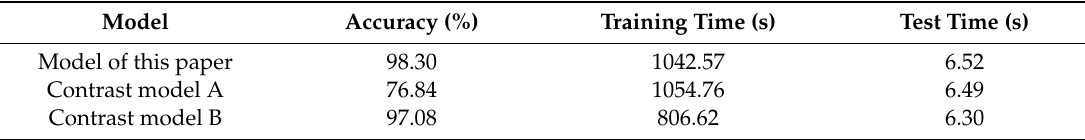
Table 7. Identification results of each comparison